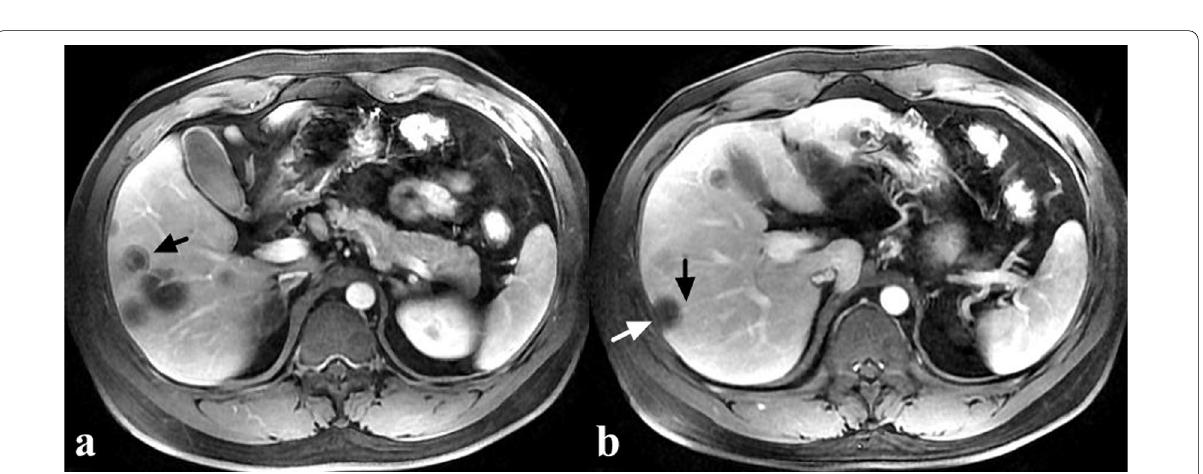
Fig. 2 A 35-year-old male HEH patient. a Target sign on portal phase image, consisted of concentric layers including markedly hypointense in central tumor regions and peripheral zones which were moderately hypointense relative to liver parenchyma (arrow). b Capsular retraction caused by a subcapsular lesion (white arrow) and lollipop sign, consisted of a well-defined tumor (as the “candy”) and an obstructed portal vein (as the “stick”) (black arrow) on portal phase